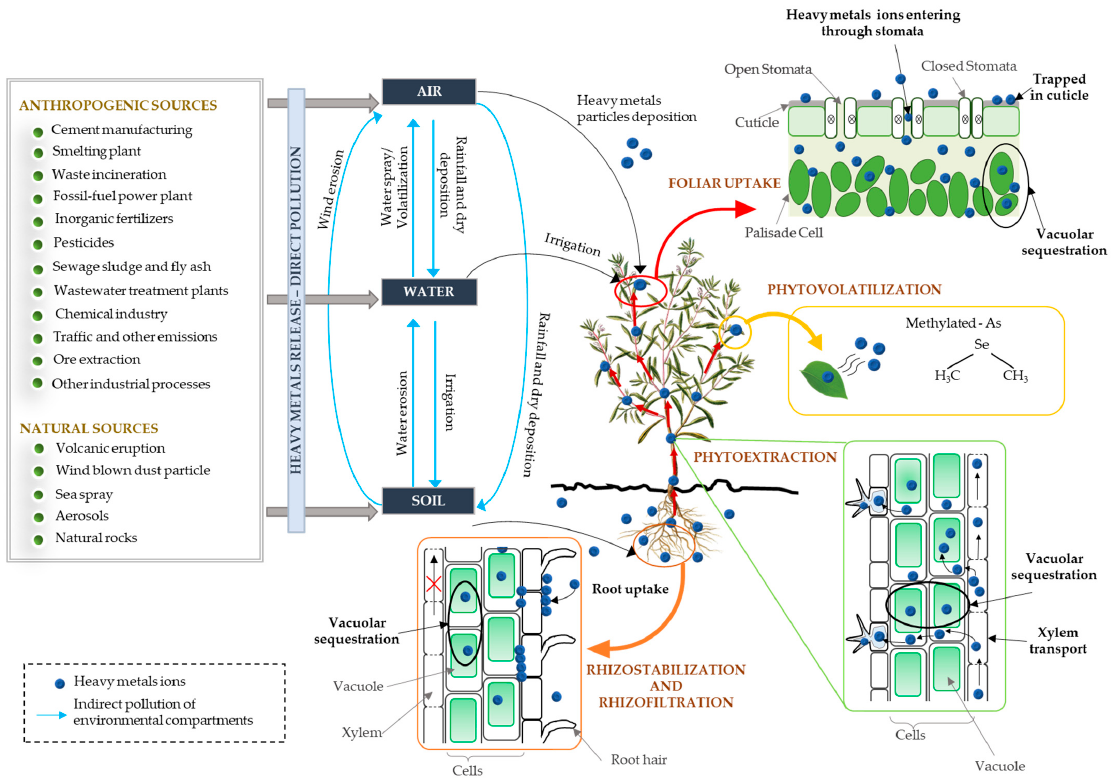
Figure 2. Sources of plants contamination with heavy metals and uptake, mobility and translocation of ions in plant parts.